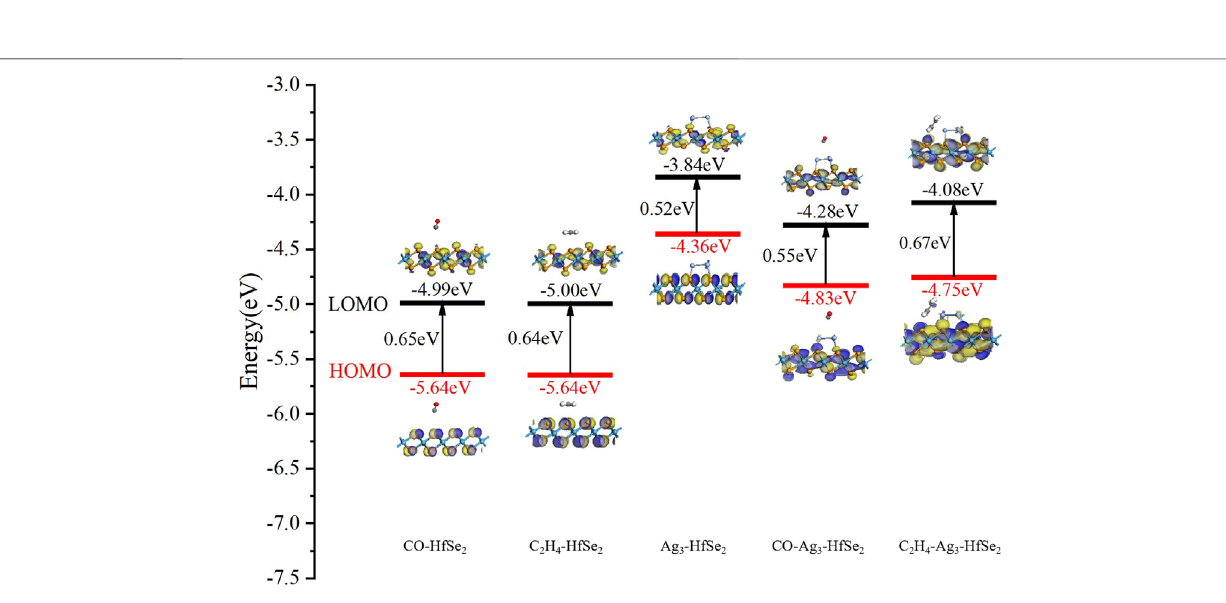
Frontiers in Chemistry |